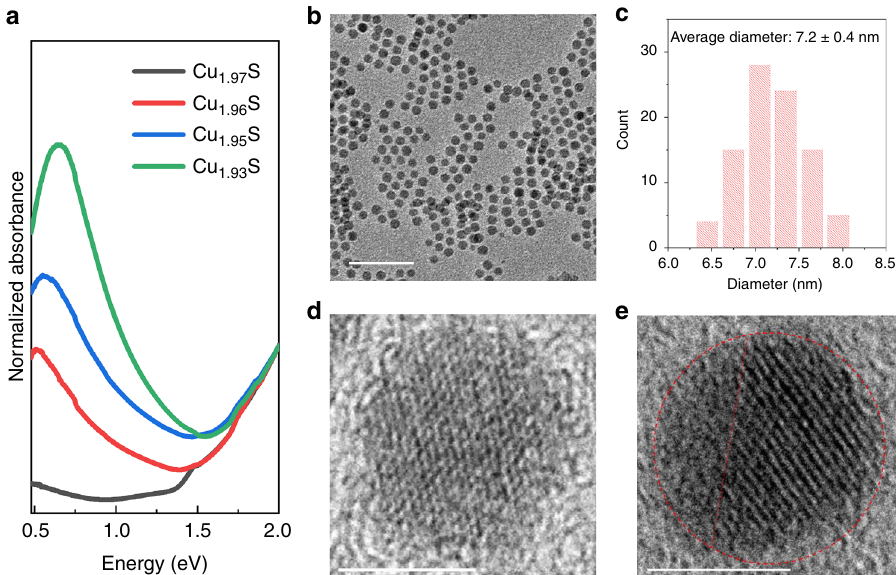
Fig. 1 Characteristics of Cu 2 − x S NCs of sub-stoichiometric composition prepared by in-situ air exposure during hot-injection synthesis. a Vis – NIR extinction spectra (normalized to 1 at 2 eV) of colloids of Cu 2 − x S NCs of four different levels of sub-stoichiometry. Spectra are plotted in terms of energy in eV, which is approximated as 1240/(Wavelength in nm). b A wide- fi eld TEM image (scale bar = 50 nm) of Cu 1.97 S NCs and c a histogram showing the NC diameter distribution determined from an analysis of the TEM image. The average diameter of the NCs is determined to be 7.2 nm with a standard deviation of 0.7 nm. Representative HRTEM image (scale bar = 5 nm) of a single NC of d Cu 1.97 S and e Cu 1.93 S. In e the NC boundary is marked by a dotted red circle and the domain boundary is marked by the dotted red